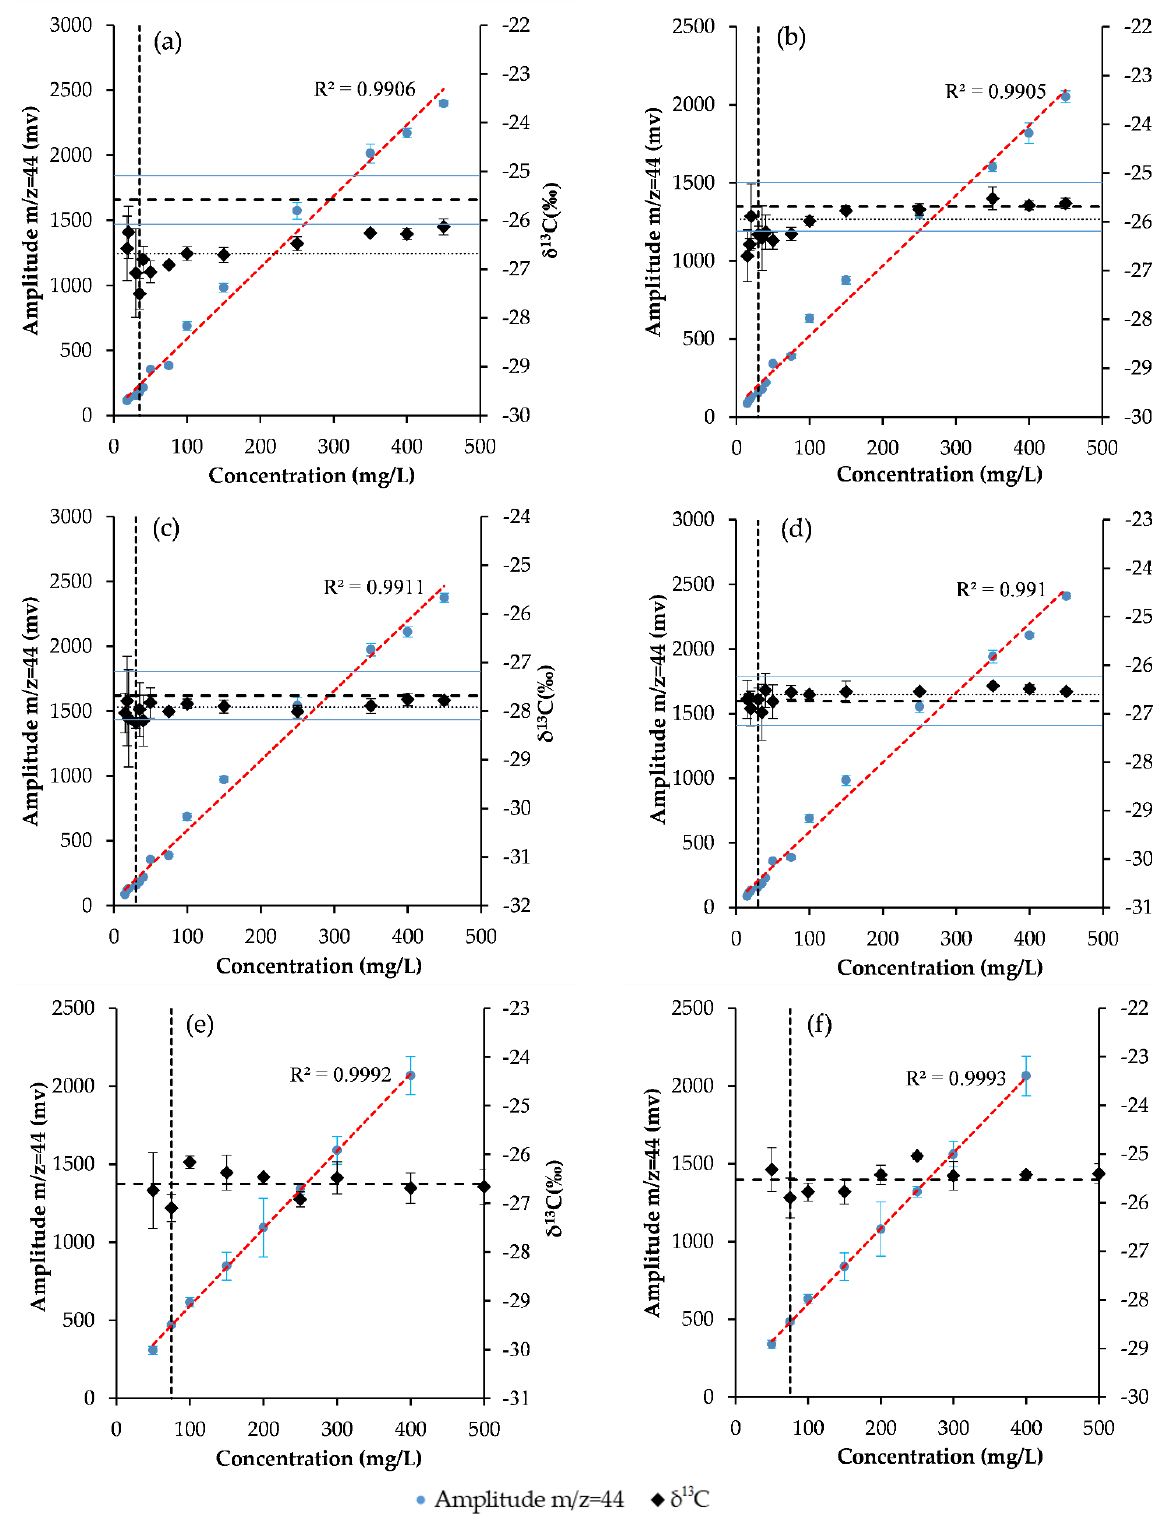
Figure 2. The method detection limits and linearity range of HCHs. ( a ) α -HCH ( b ) β -HCH, ( c ) γ -HCH, ( d ) δ -HCH. ( e ) (+) α -HCH ( f ) ( − ) α -HCH. The diamonds represent the δ 13 C values in per mil and the squares show the amplitude of mass 44 in mV. The dashed lines represent the intervals of δ 13 C measured by EA-IRMS ± 0.5‰. Each point was measured three times, and the error bars represent the standard